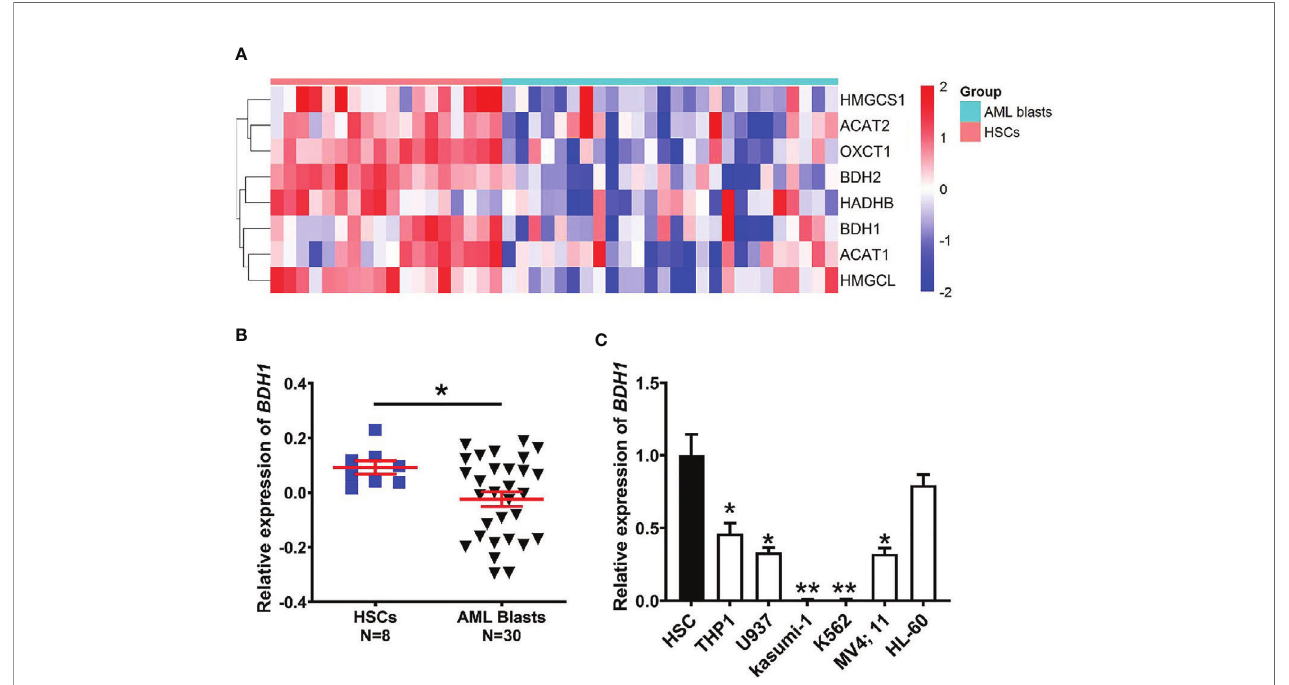
FIGURE 1 | The expression of BDH1 is downregulated in AML as compared with normal HSCs. (A) A heatmap of the hierarchical clustering of 8 key genes involved in ketone body metabolism. Input data are the mRNA expression values of AML blasts over normal HSCs. Upregulated genes are designated with red color, while blue color indicates downregulated genes. (B) The mRNA expression analysis of BDH1 in 30 cases of AML blasts and 8 cases of normal HSCs in GSE65409 database. The expression values in GSE65409 were log2-transformed and mean centered. The P values were detected by t -test. (C) The expression level of BDH1 was determined by qRT-PCR in AML cell lines and normal HSCs, normalized to GAPDH . * p < 0.05, ** p <